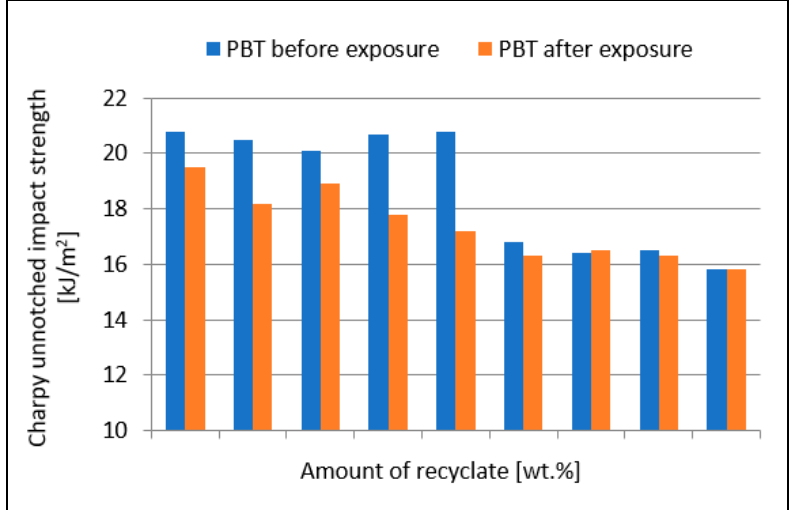
Figure 5. Dependence of the unnotched impact strength of PBT on the amount of the recycled material before and after the samples were exposed to elevated temperature ( − 30 °C).